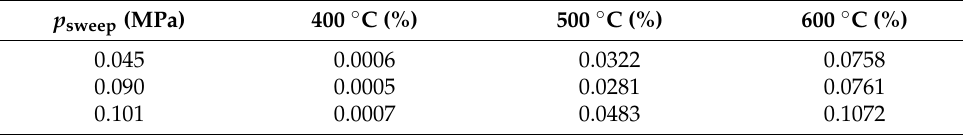
Table 5. Relationship between H 2 yield and p sweep with change in reaction temperature. p sweep